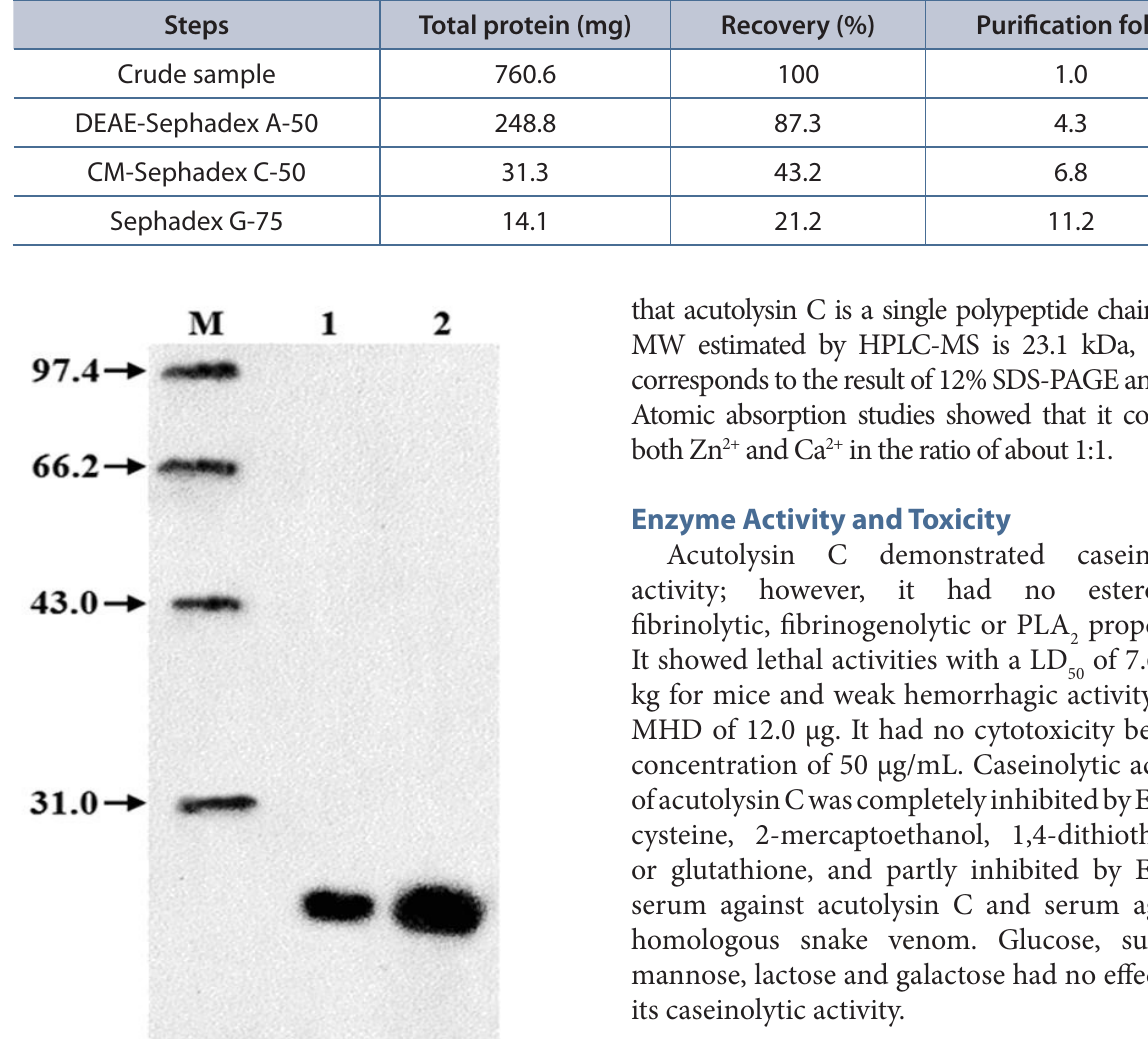
Table 1. Acutolysin C yield in purification procedure by chromatography (DEAE-Sephadex A-50, CM- Sephadex C-50 and Sephadex G-75)